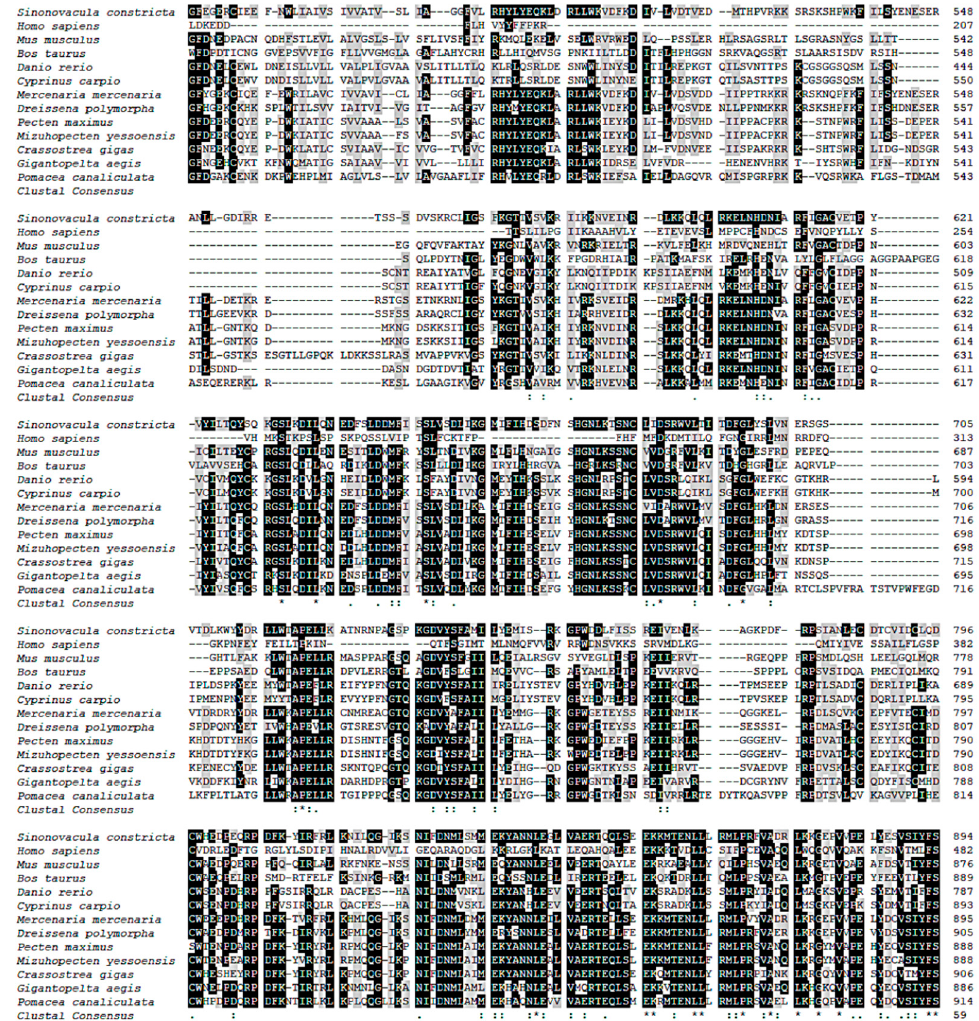
Figure 1. Multiple cGMPase amino acid sequence alignments from S. constricta and other species. Identical amino acid residues are highlighted in black and similar amino acids in gray. Accession